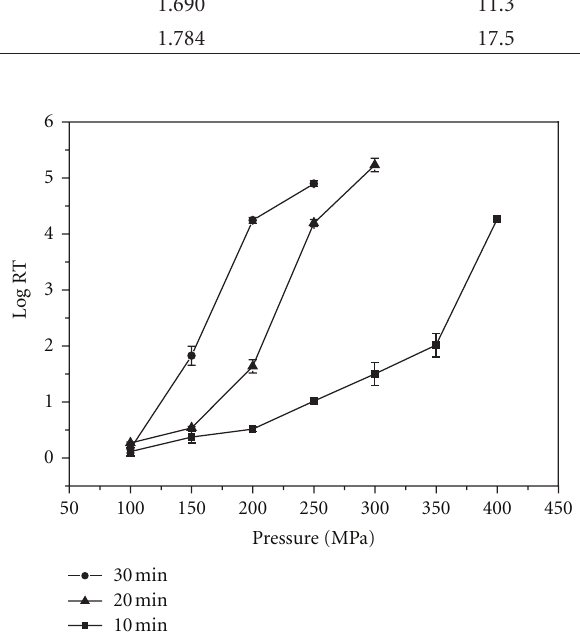
Figure 1: Death curve of A. tumefaciens caused by HHP treatment. Process temperature 25 ◦ C. logRF = log( N 0 /N ). Data are shown as mean ± SD ( n =